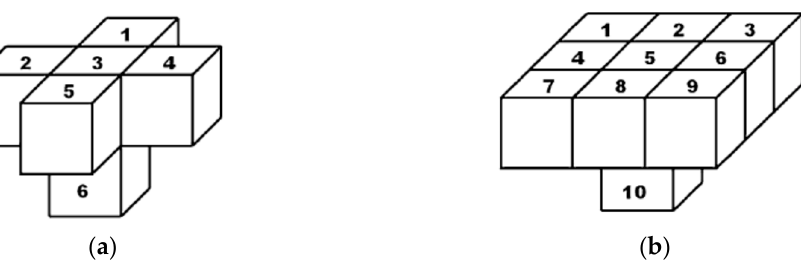
Figure 4. Two approximations of the extraction in an open-pit mine. ( a ) In order to extract block 6 first must be extracted blocks 1 to 5, therefore there are five precedence arcs from block 6. ( b ) In order to extract block 10 first must be extracted block 1 to 9: there are nine precedence arcs from block 10 [43].